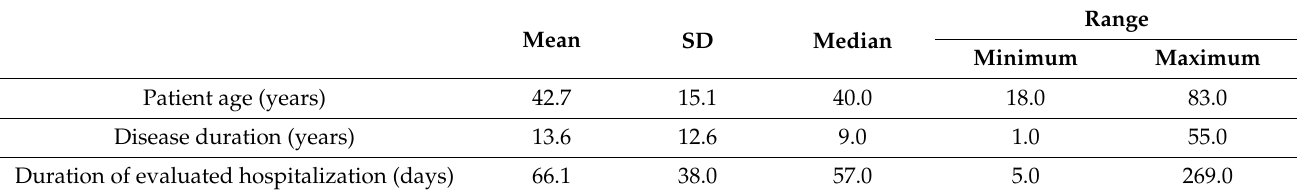
Table 1. Characteristics of the patients (N = 338) included in the